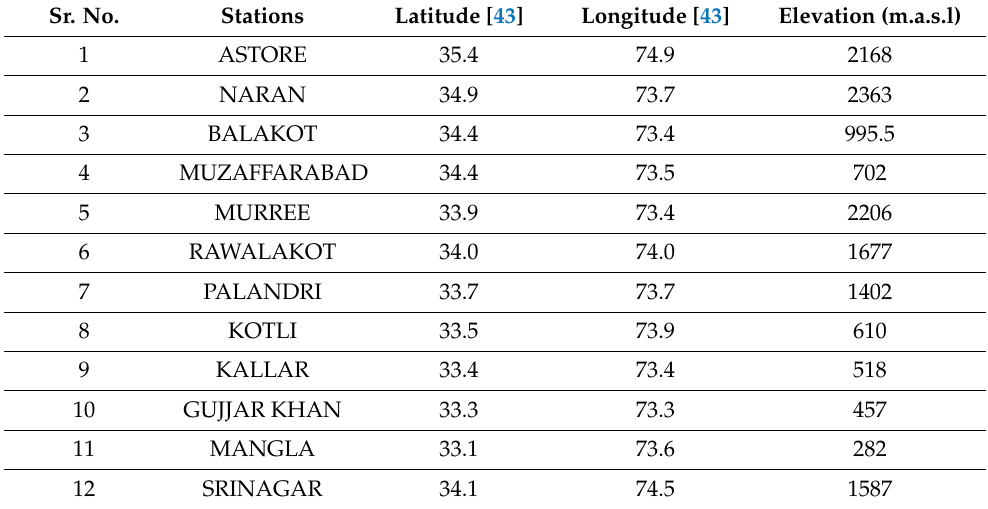
Table 1. Climate stations of Pakistan Meteorological and Indian Meteorological Department in the study